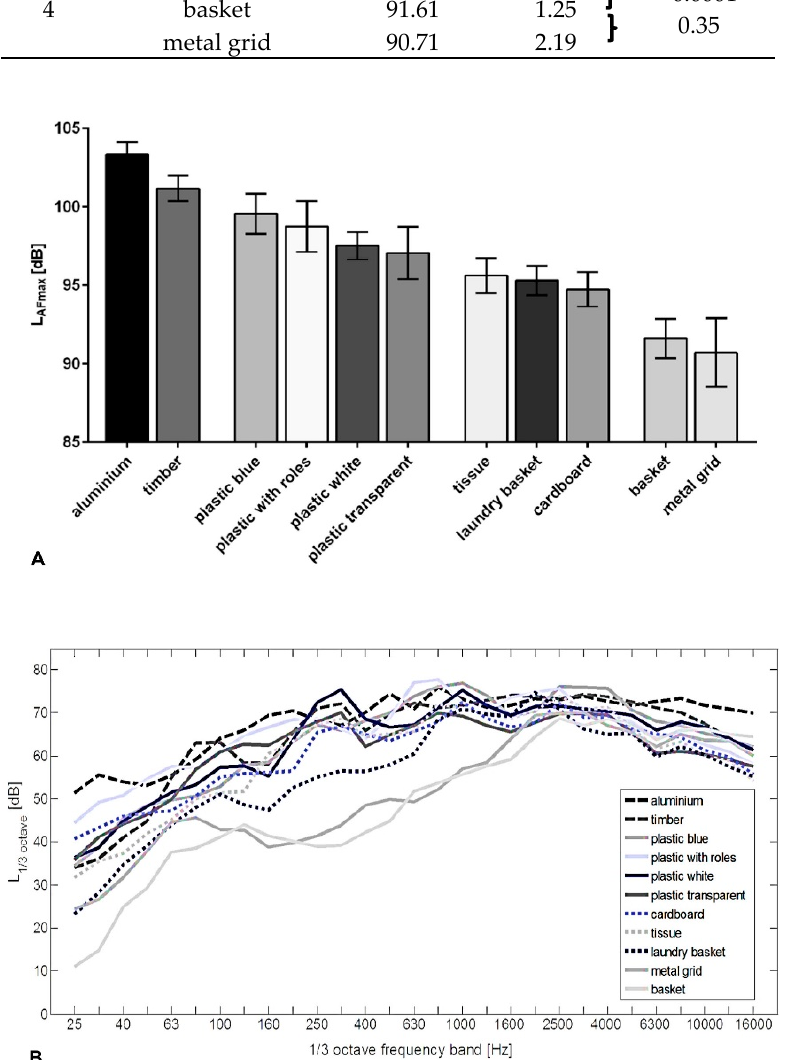
Figure 3. ( A ) LEGO Duplo toy brick dropping noise level measurements (L AFmax ) of different storage cases ( n = 11), arranged in descending order and in groups of similar L AFmax ; and ( B ) band pass (1/3 octave band width) frequency analyses of the noise level measurements.